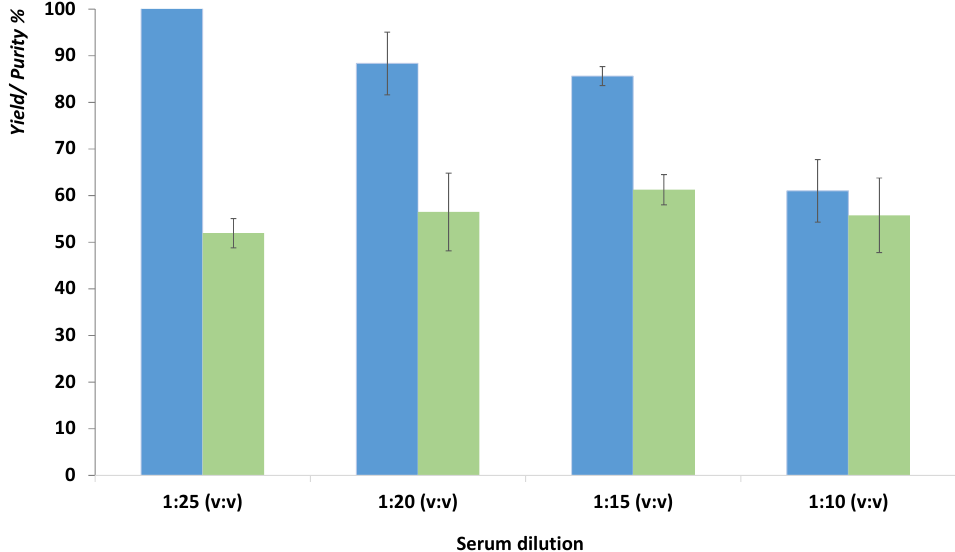
Figure 4. Extraction yield ( Yield% ) ( ◼ ) and purity ( Purity% ) ( ◼ ) of bovine serum albumin in the ionic-liquid-rich phase extracted from bovine serum with the aqueous biphasic systems comprising [N 4444 ][Ac] as function of the bovine serum dilution.